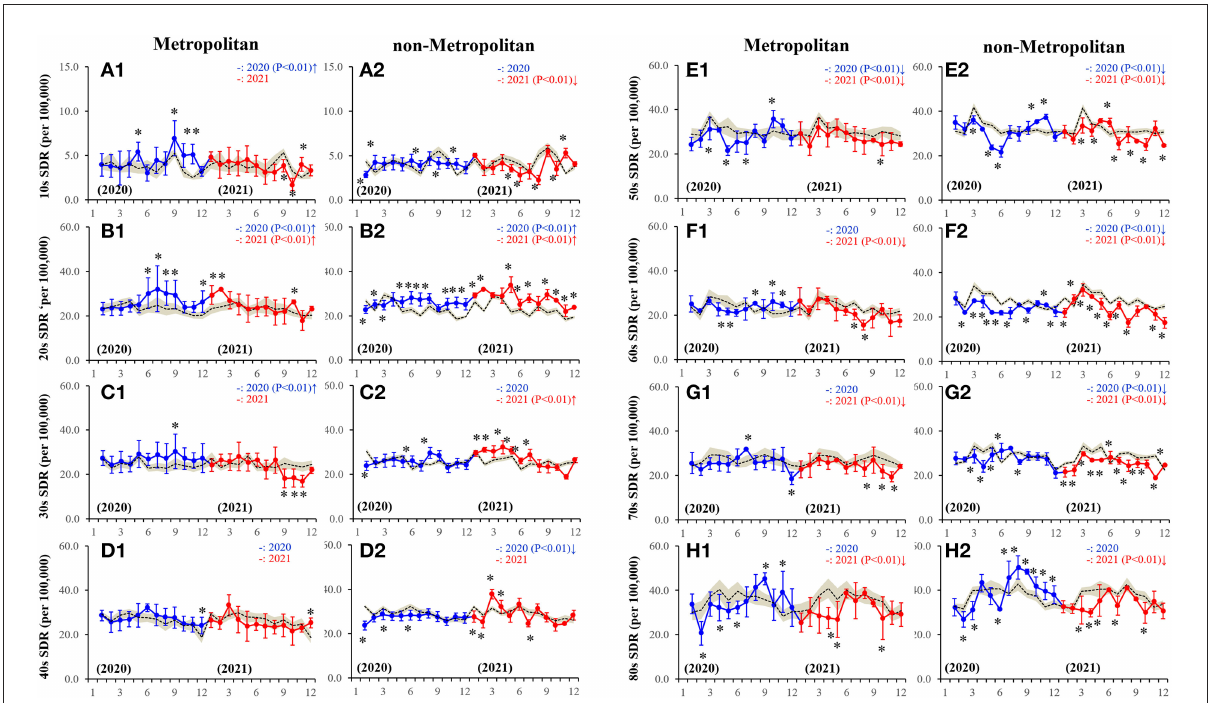
FIGURE1 Fluctuations of monthly males SDR disaggregated by regions, metropolitan (A1-H1) and non-metropolitan (A2-H2) regions, and ages, 10s (A1-A2) , 20s (B1-B2) , 30s (C1-C2) , 40s (D1-D2) , 50s (E1-E2) , 60s (F1-F2) , 70s (G1-G2) and 80s (H1-H2) , during the COVID-19 pandemic (2020–2021). Dotted, blue and red lines indicate the average predicted and observed SDRs in 2020 and 2021, respectively. Brown areas, blue and red bars indicate the 95% CI for the predicted and observed SDRs in 2020 and 2021, respectively. Ordinates indicate the standardized suicide mortality (SDR per 100,000 people), and abscissas indicate the month. * p < 0.05, significant change of monthly SDR in comparison to predicted SDR using a linear mixed-effects model with Scheffe’s post-hoc test. ↑ and ↓ indicate significantly higher and lower observed annual SDR in comparison to predicted annual SDR,